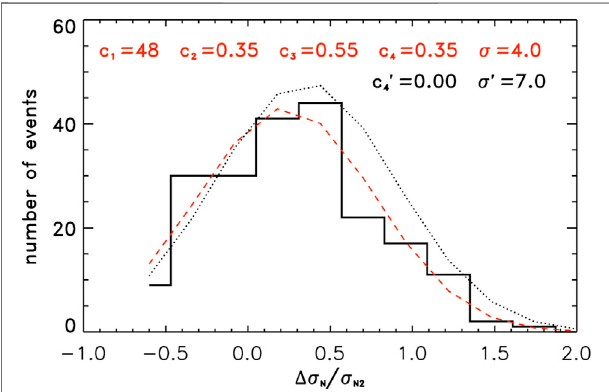
FIGURE 4 | A histogram of frequency of occurrence of the observed ratio Δ σ N / σ N2 (black solid curve) with a superimposed skewed normal (Gaussian)-distribution, f( Z ) (red dashed curve), where Z ≡ Δ σ N / σ N2 ; c 1 , c 2 , c 3 , and c 4 are the coef fi cients shown in Eq. 1 . The black dotted curve is for the same Gaussian (i.e., the same values of c 1 , c 2 , and c 3 ), except now c 4 is setequaltozero. σ givesameasureofhowwellthe fi t-curveapproximatesthe observedhistogramandisgivenby Eq.2 .Theredcoef fi cientsholdforthered dashed skewed Gaussian and the black coef fi cients are for the simple Gaussian (second line at the top), where c 1 , c 2 , and c 3 are the same in both cases. Note that both black and red curves are approximately